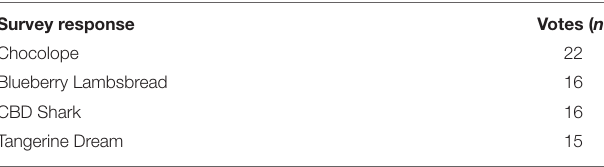
TABLE 3 | Strain(s) or product(s) least effective for treating anxiety for survey